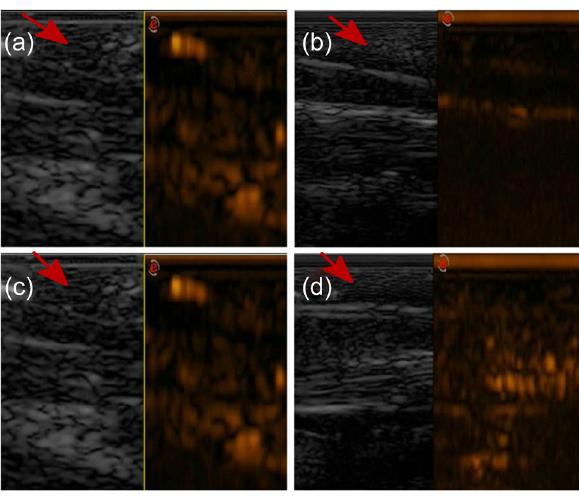
Figure 8: Contrast - enhanced ultrasound imaging of the Achilles tendons in rabbits: ( a ) experimental group ( partial incision of the Achilles tendon and TBCMs ) , ( b ) control group ( partial incision of